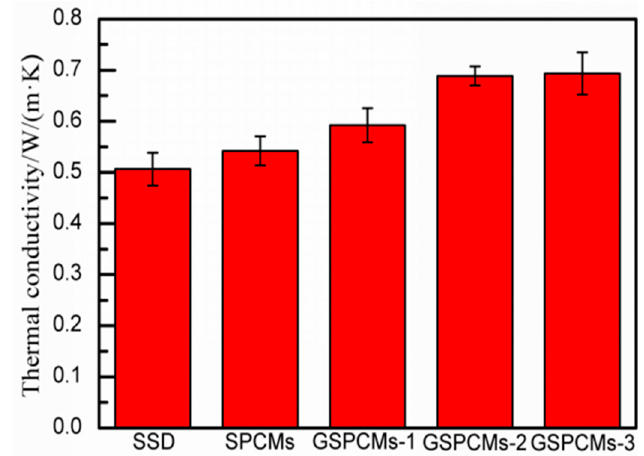
Figure 9. Thermal conductivity of the prepared S-PCMs and GS-PCMs.